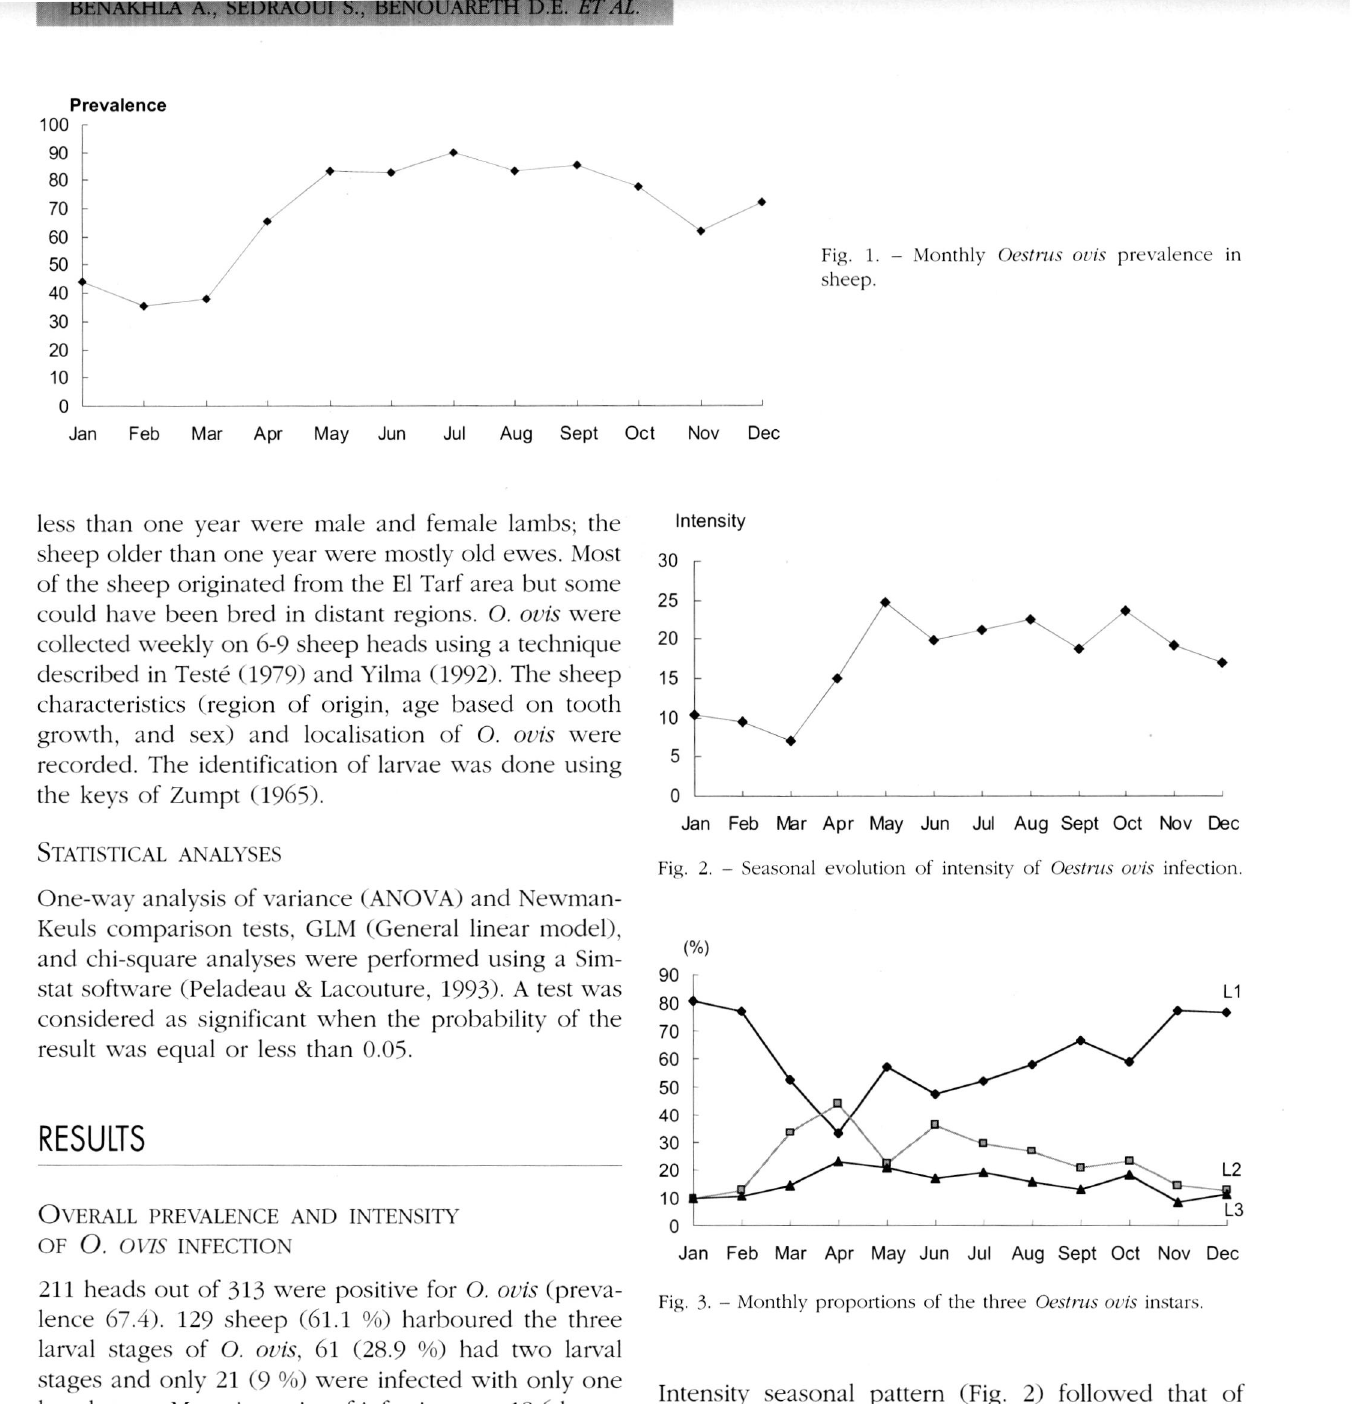
Fig. 1. - Monthly Oestrus ovis prevalence in sheep.